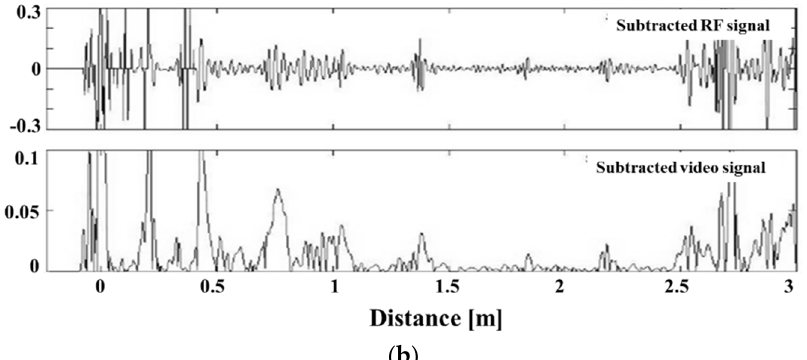
Figure 3. ( a ) Typical guided wave signal acquired from a pipe by a magnetostrictive guided wave transducer and ( b ) simple subtraction of guided waves from the reference signals show residual components due to differences in the experimental conditions.